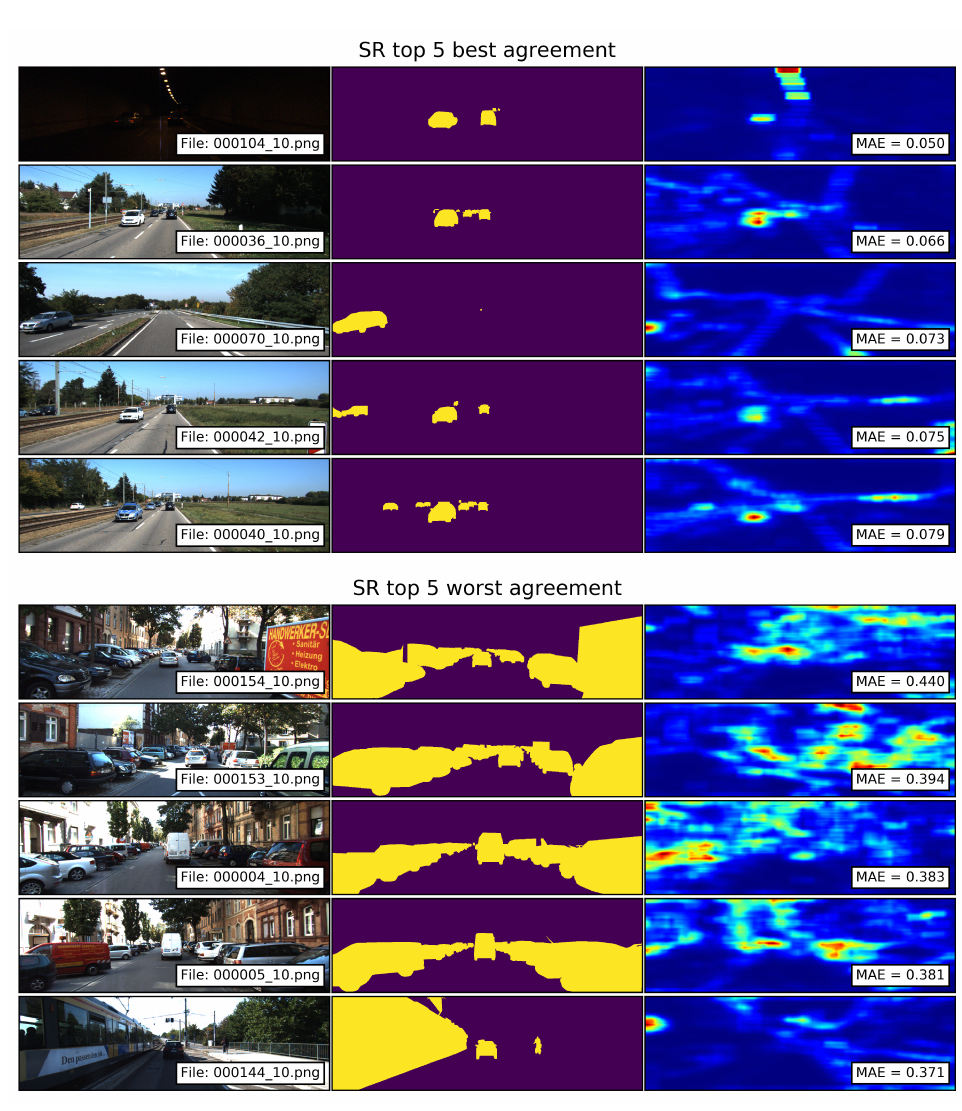
Figure 11. Top 5 best and worst agreements between the segments of traffic participants and the saliency maps computed with the SR model. Smaller MAE values correspond to a better